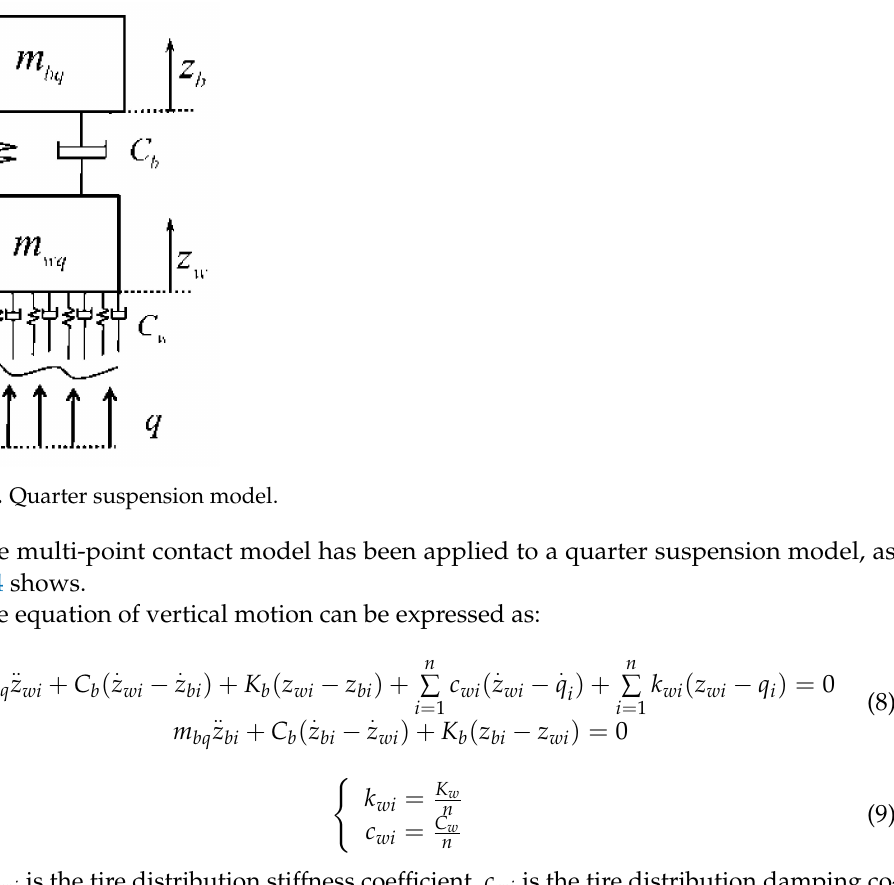
Figure 3. Tire–road vertical dynamics model.